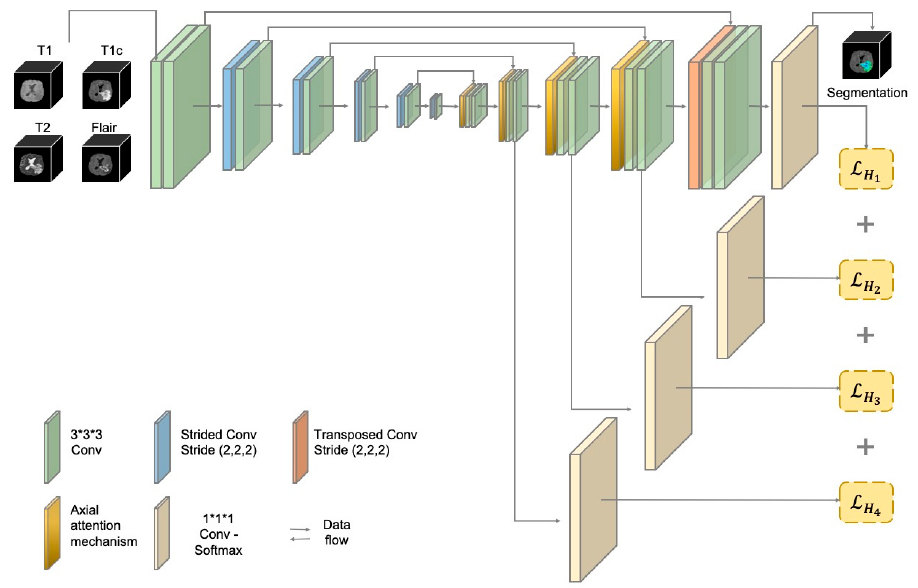
Figure 2. The structure of the proposed AABTS-Net.